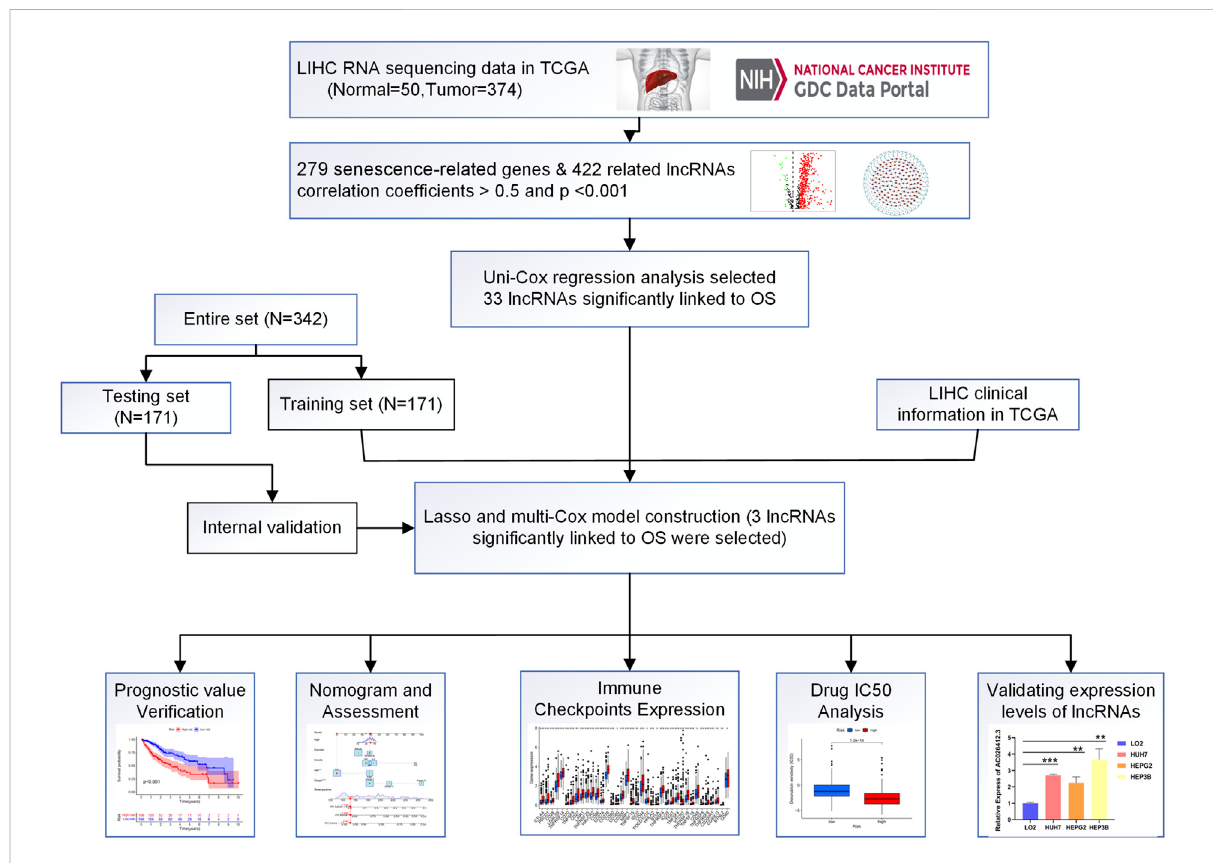
FIGURE 1 Flow diagram of the study (LIHC: Liver hepatocellular carcinoma; N: Number; OS: Overall